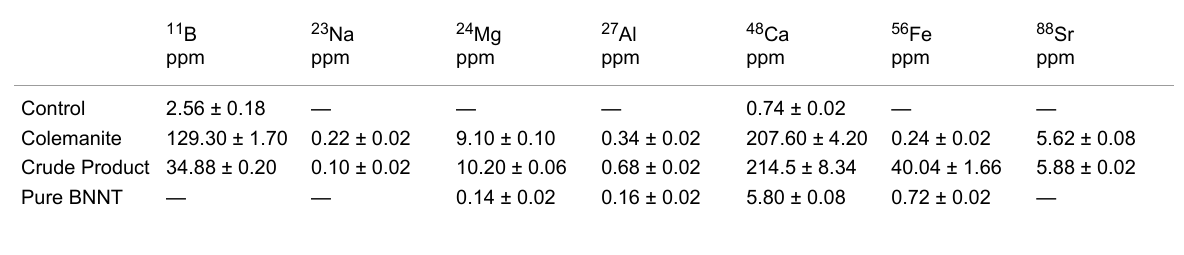
Table 1: ICP-MS elemental analysis of colemanite, crude and purified